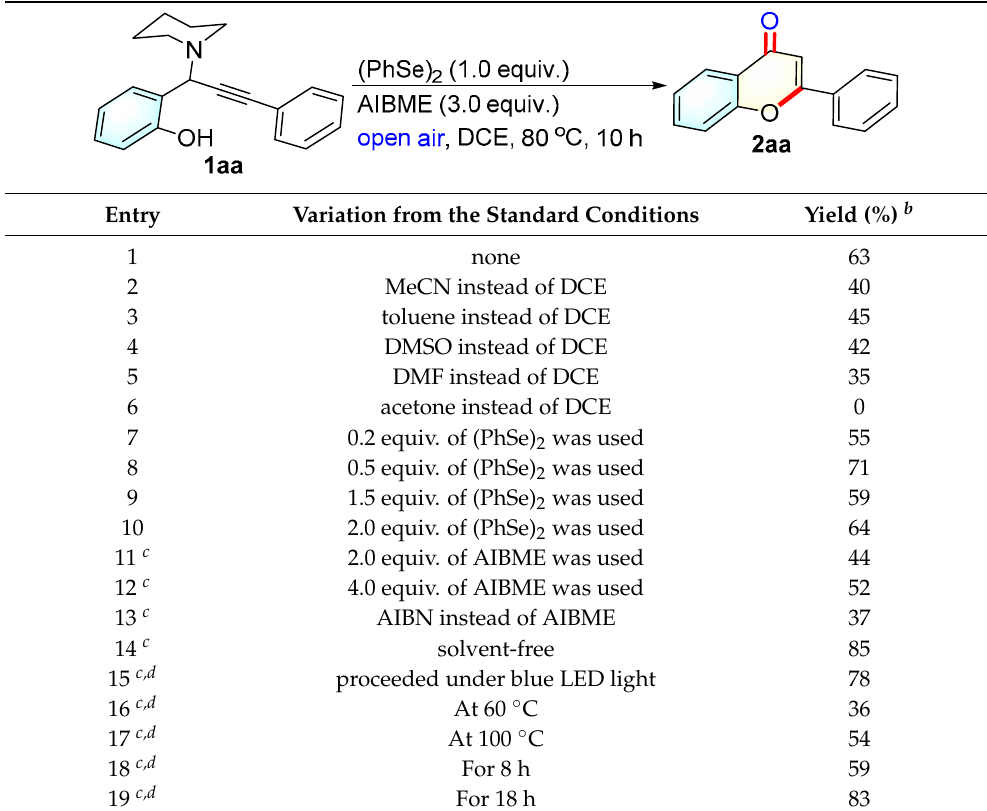
Table 1. Optimization of reaction conditions a .